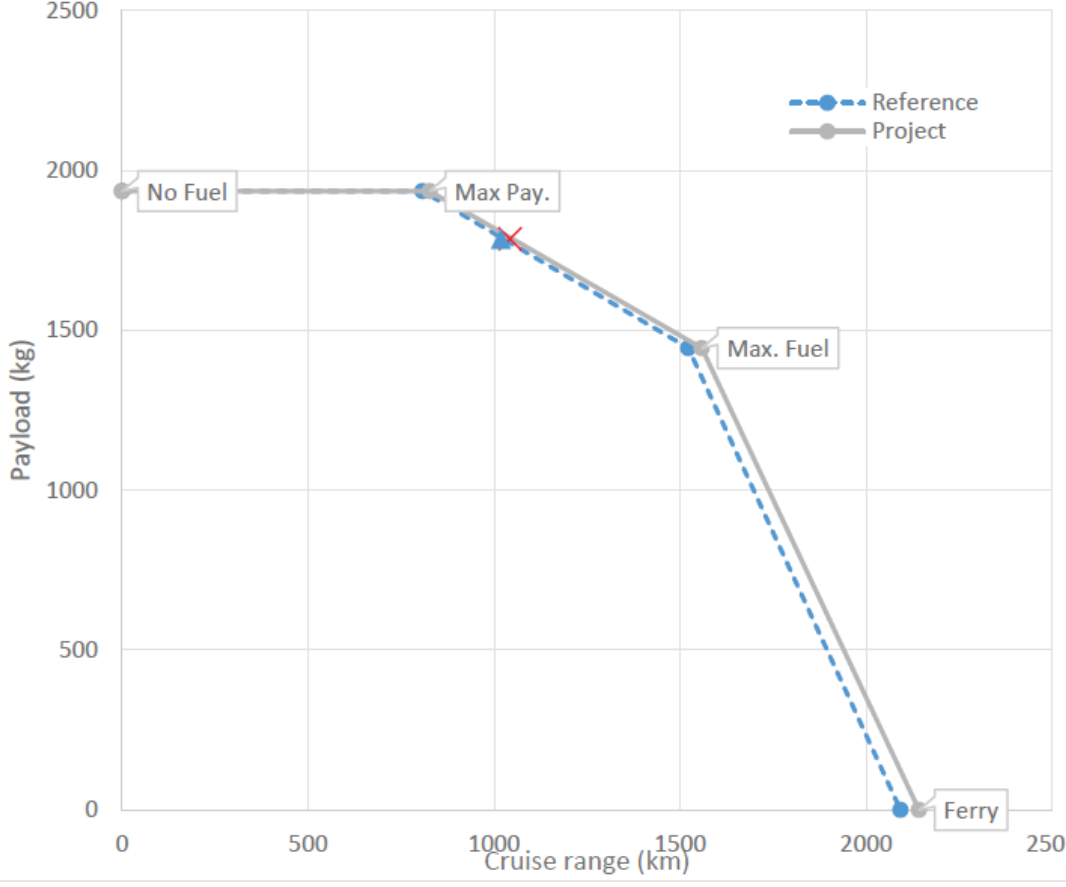
Figure 14. Cruise – range diagram for the reference wing and the optimal winglet (project) configuration.